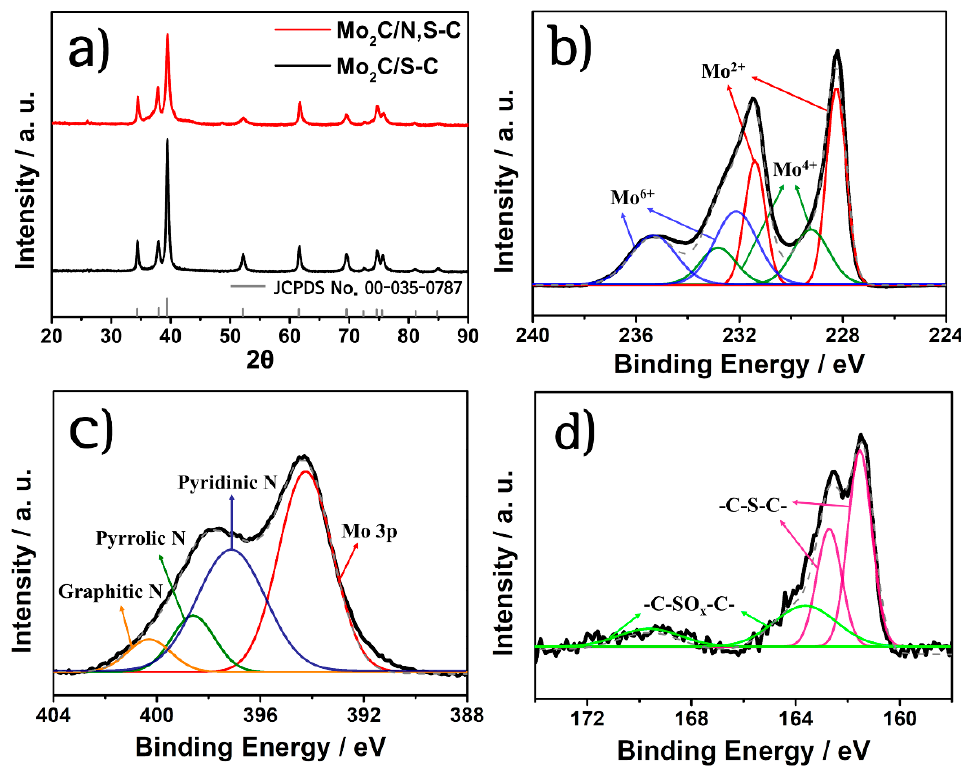
Figure 2. ( a ) XRD patterns of Mo 2 C/N,S-C and Mo 2 C/S-C. ( b – d ) High-resolution XPS spectra of Mo 2 C/N,S-C for Mo 3d, N 1s and S 2p. Dotted lines denote raw data and other lines represent deconvoluted data.